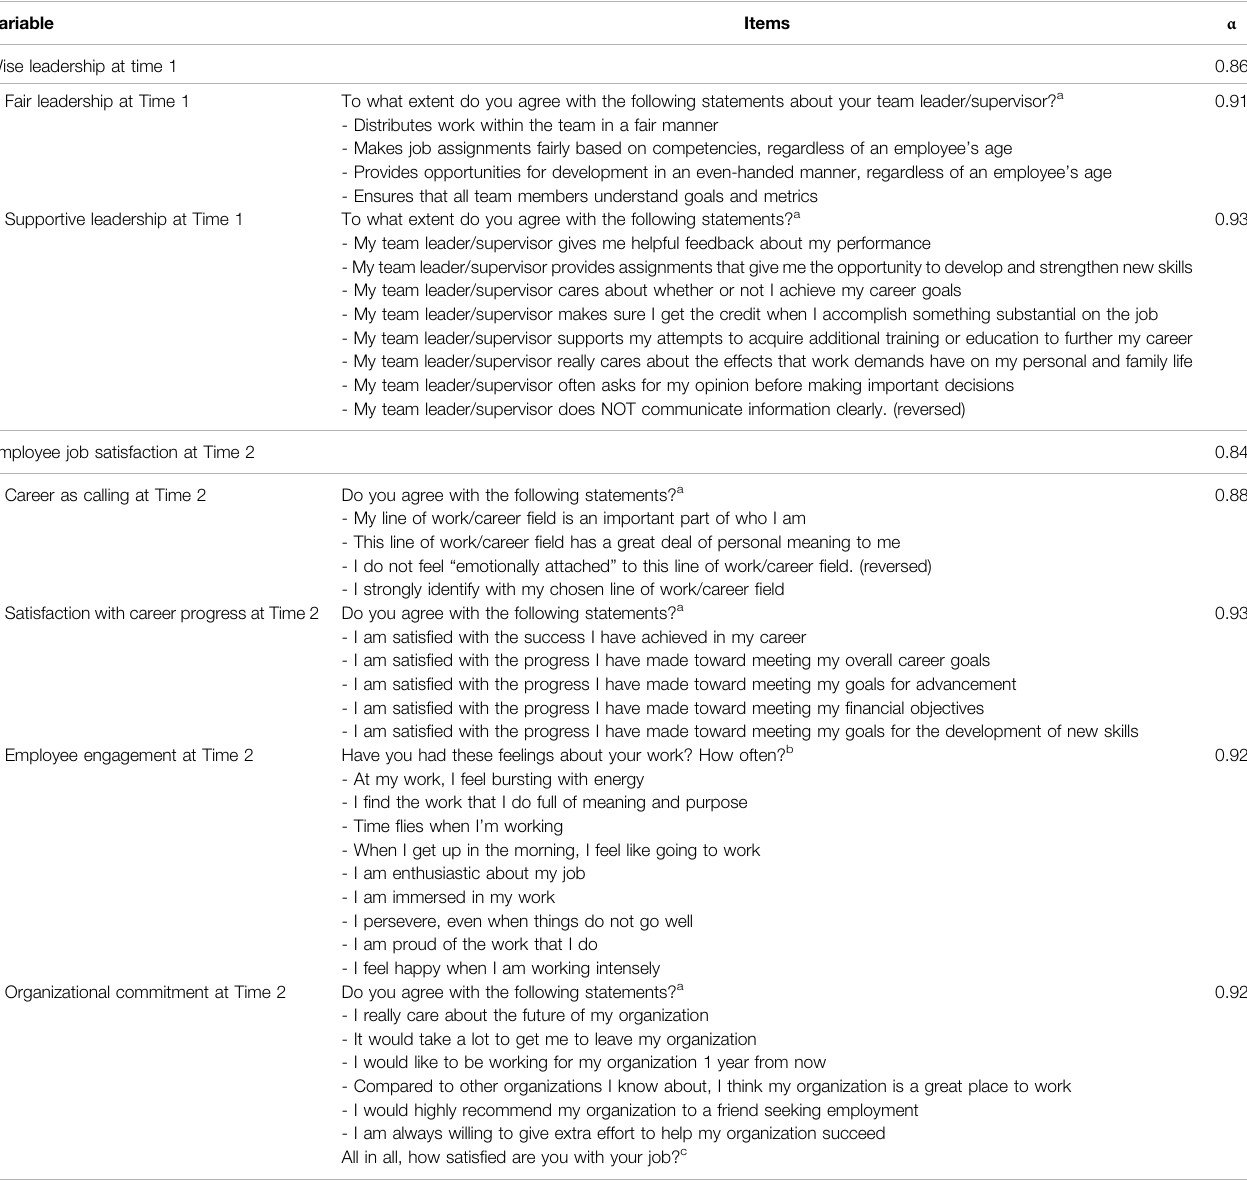
TABLE 3 | Assessment of wise leadership and employee job satisfaction. Variable Items Wise leadership at time